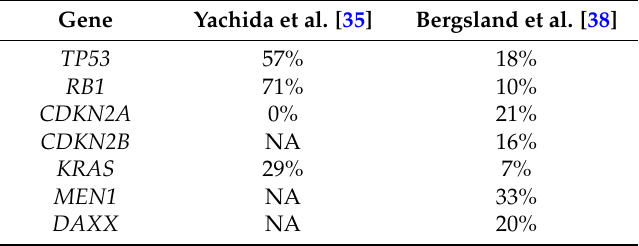
Table 3. Prevalence of common gene mutations for pNEC by targeted-sequencing data. Gene Yachida et al. [35] Bergsland et al. [38] TP53